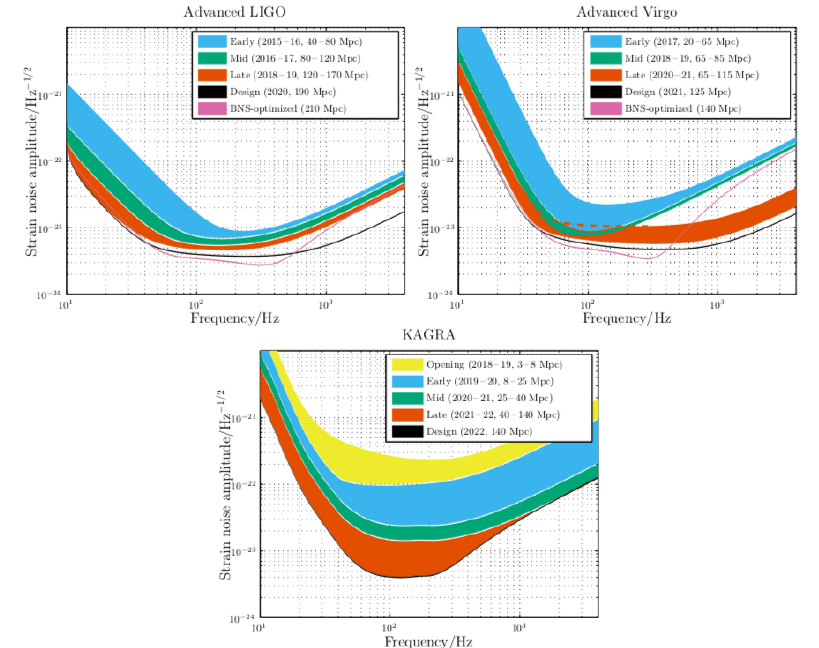
Figure 1. The target strain sensitivities of LIGO, Virgo and KAGRA as a function of fre- quency during the following data taking. The binary neutron star (BNS) range is the average distance in Mpc, to which these signals could be detected. The figure is extracted form the reference [1]